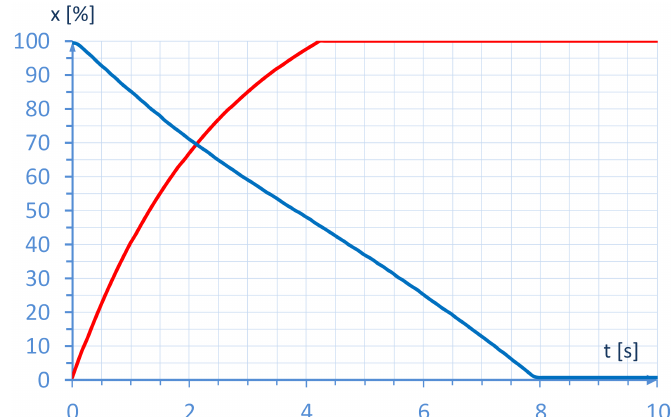
Figure 5. Illustration of the directionality effect for reverse-action actuator type R1-400 from Polna S.A. The nominal volume of the pressure chamber is 0.800 dcm 3 . The red line depicts retraction and the blue one represents expansion of the